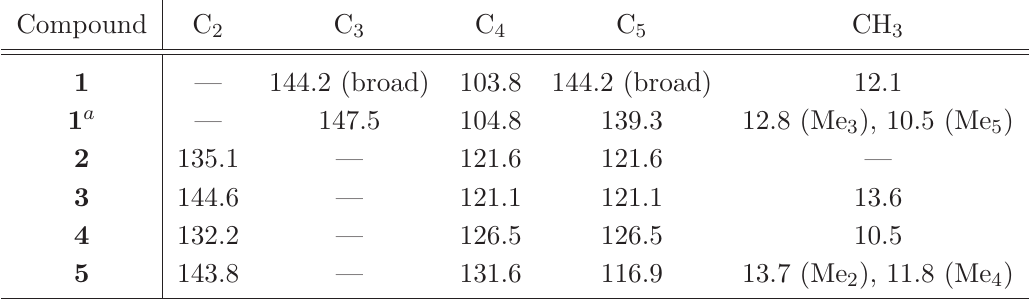
-H/N -H tautomerism. Not in the case of 1 3